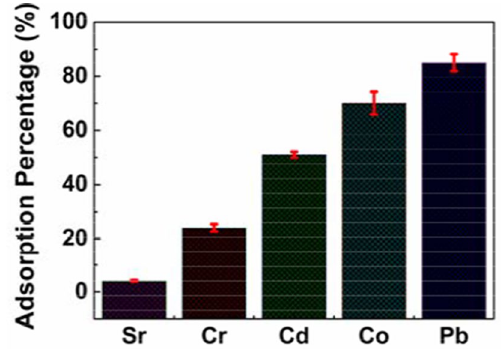
Fig. 7 Selectivity of 3D AFC for Pb2 + compared to Sr2 + , Cr2 + , Cd2 + , and Co2 + in oral medical